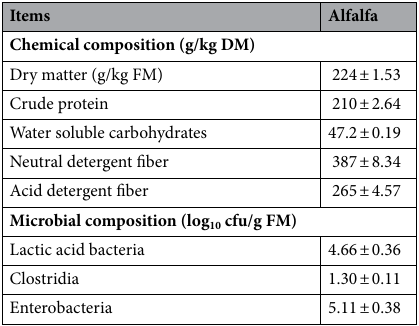
Table 1. Chemical and microbial composition of pre-ensiled alfalfa. Means ± standard deviation, n = 3; DM, dry matter; FM, fresh matter; cfu, colony forming